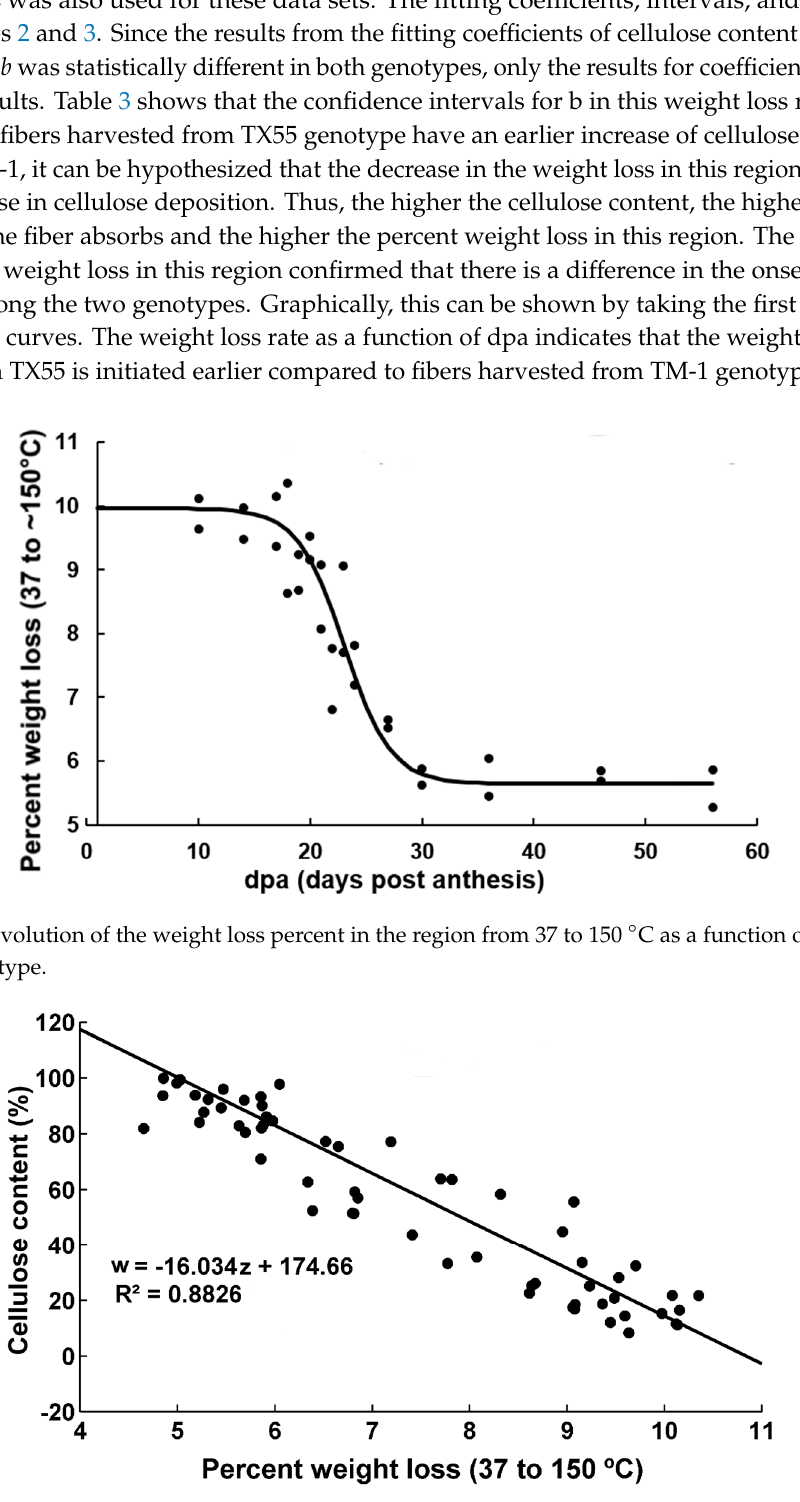
Figure 8. Percent crystallinity as a function of the weight loss percent in the region from 37 to ~150 °C.